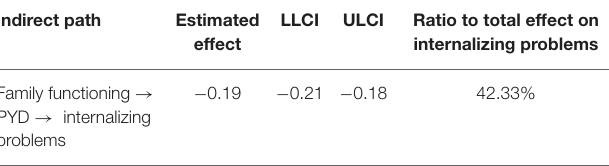
TABLE 3 | Bootstrapping indirect effect and 95% confidence interval (CI) for the mediation model. Indirect path